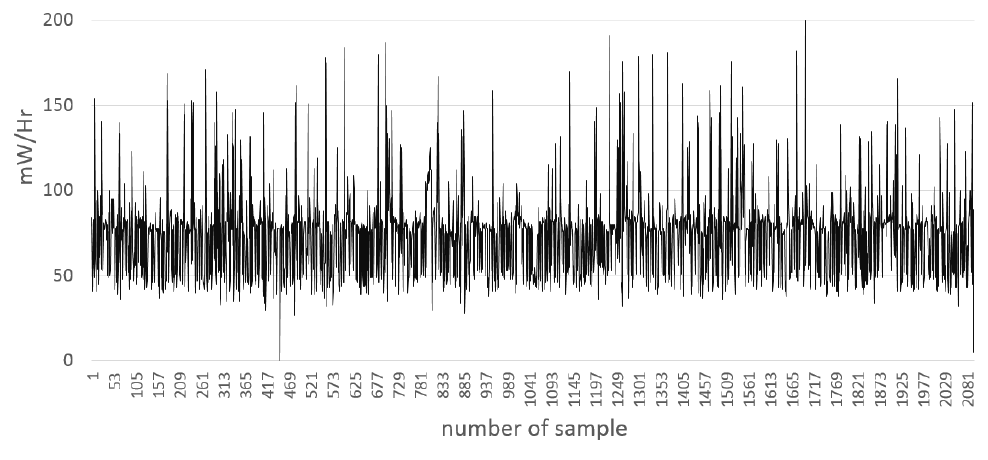
Figure 14. Example of the power consumption chart.